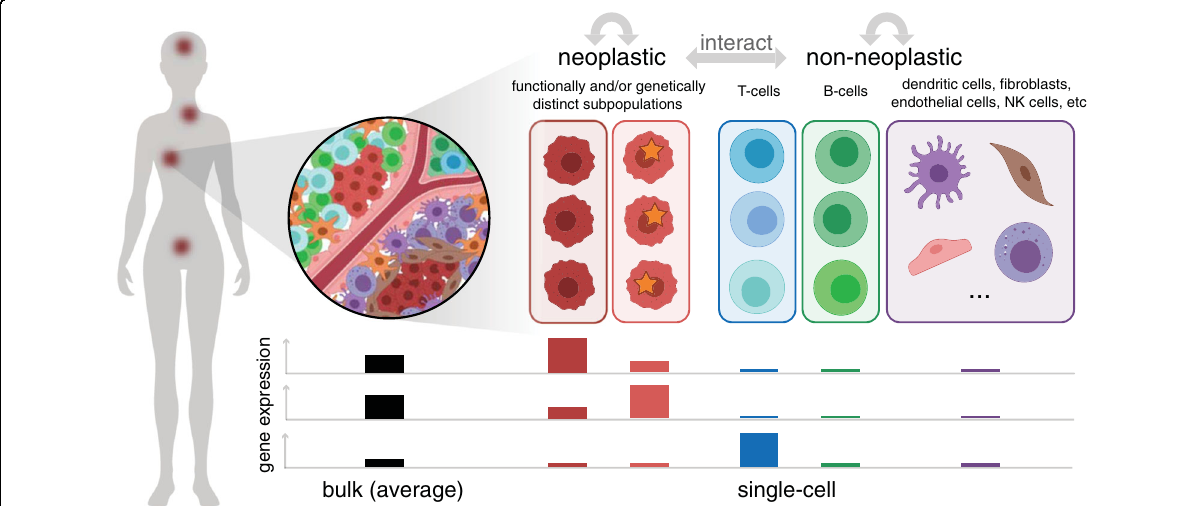
Fig. 1 Cancer may manifest as multiple spatially distinct tumors composed of multiple functionally and/or genetically distinct neoplastic subpopulations as well as diverse nonneoplastic cell types and states that interact to impact clinical outcomes. In this illustration, (left) a single patient presents with cancer at multiple sites. (top right) Zooming into one site, multiple cell types, both neoplastic and nonneoplastic, can be observed. Within the neoplastic cells, two distinct subpopulations marked by different somatic mutations, indicated with a star, are present. Likewise, within nonneoplastic cells, multiple distinct T-cell and B-cell subtypes and states, indicated with different shades of colors, are present. (bottom) Bulk measurements provide the average quanti fi cation of gene expression, which potentially obscures proportional and subpopulation or state-speci fi c differences. The expression levels of three genes determined from bulk and pooled single-cell measurements for the two different neoplastic subtypes and major nonneoplastic cell types (T-cells, B-cells, and other) are illustrated as an example. The fi rst two genes appear to be highly expressed in the bulk sample but are actually highly expressed in only one of the neoplastic subpopulations. In contrast, the third gene appears to show low expression in the bulk sample but is actually highly expressed among T-cells, which are proportionally low in abundance. In this manner, single-cell measurements could enable the fi ner, unbiased characterization of transcriptional features that underlie important cancer